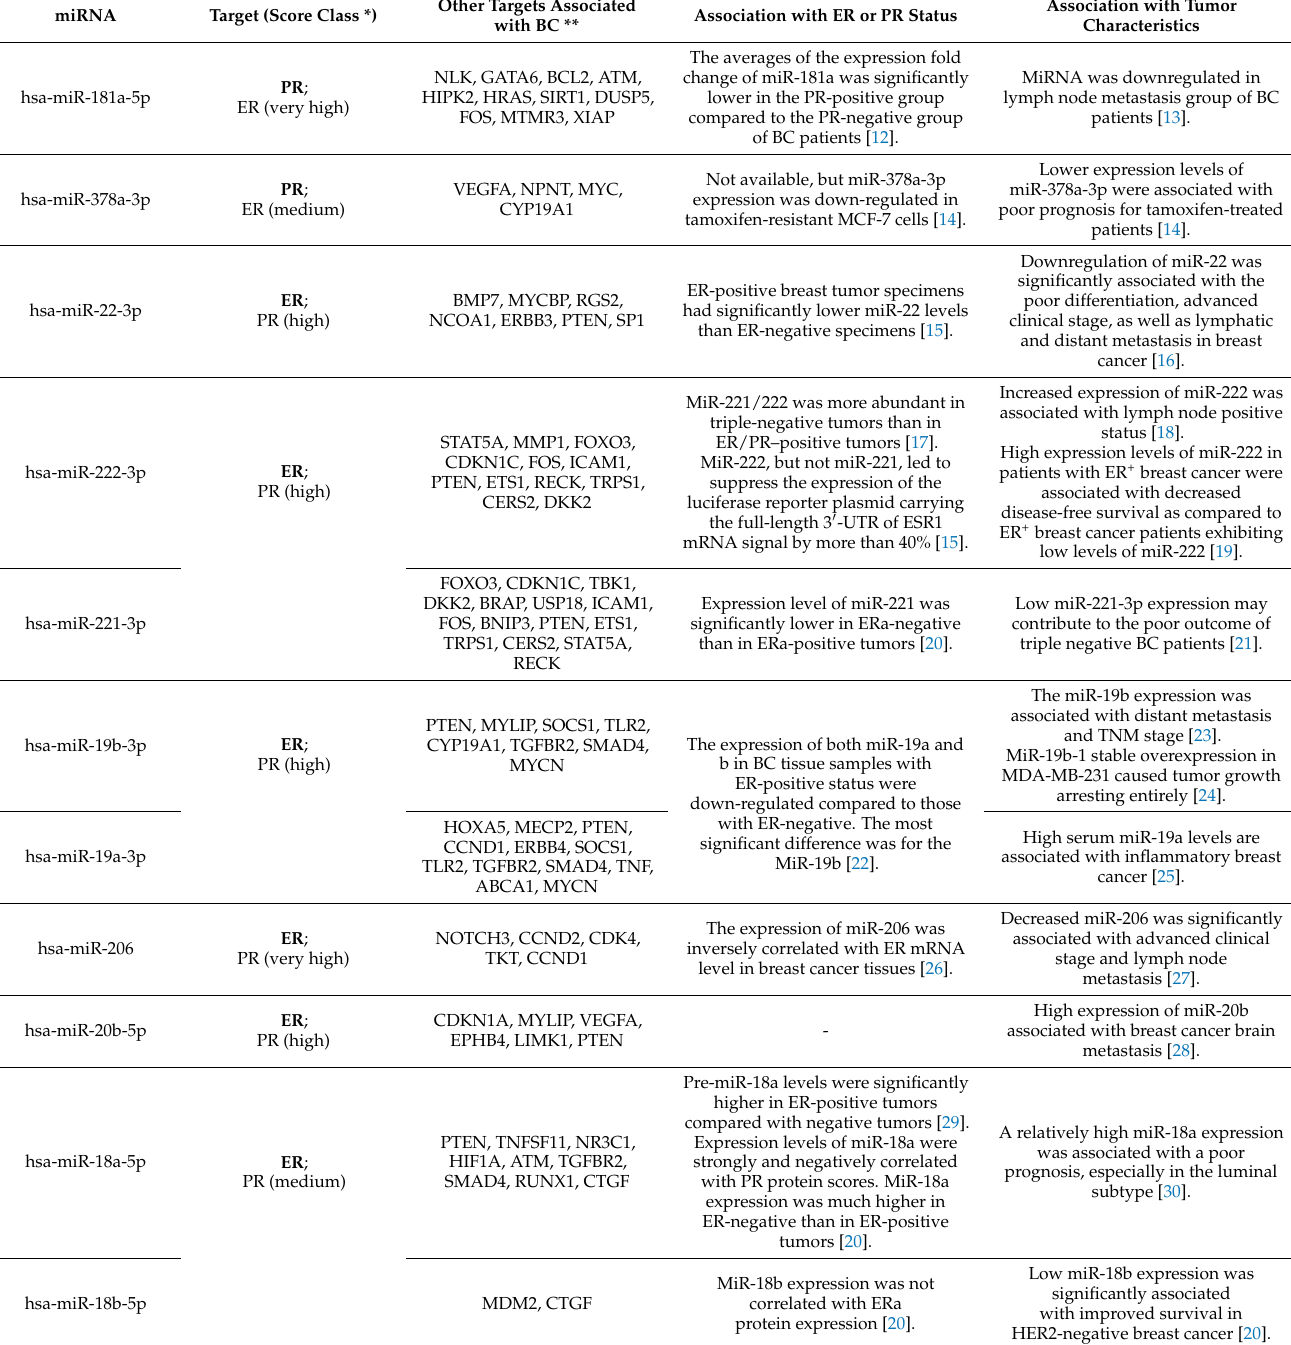
Table 2. The miRNAs regulating the expression of ER and